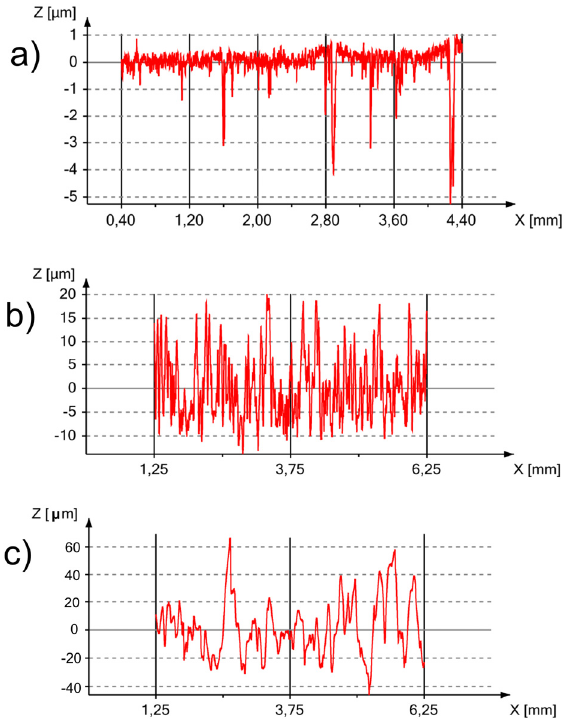
Figure 8. Optical profiler surface scans and X-profiles of the Ti23Mo 3BG nanocomposites before ( a ) and after electrochemical etching ( b ) as well as after additional Ca-P deposition ( c ). At different processing stages changes occur in the surface porosity (Figure